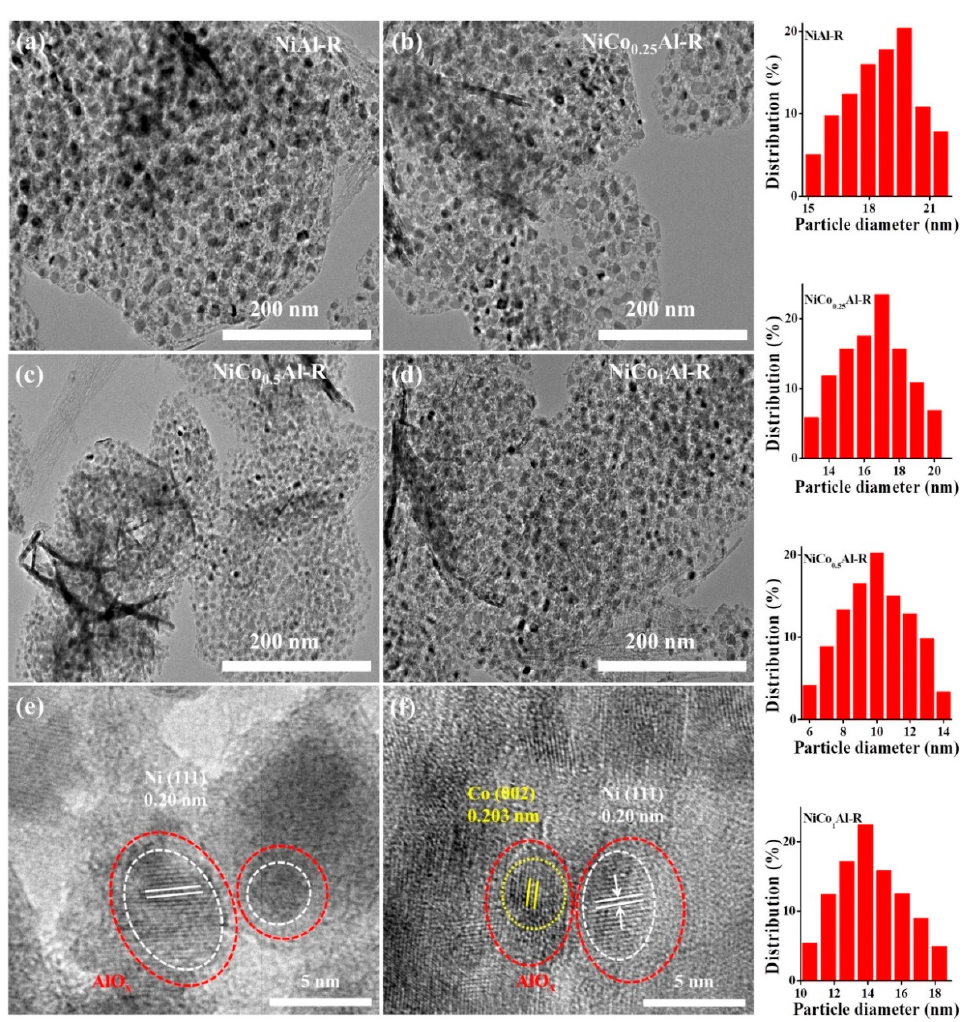
Figure 6. TEM images of NiCo x Al-R catalysts: ( a ) NiAl-R, ( b ) NiCo 0.25 Al-R, ( c ) NiCo 0.5 Al-R, ( d ) NiCo 1 Al-R, ( e ) NiAl-R and ( f ) NiCo 0.5 Al-R. The histograms show the size distribution of Ni nano- particles.